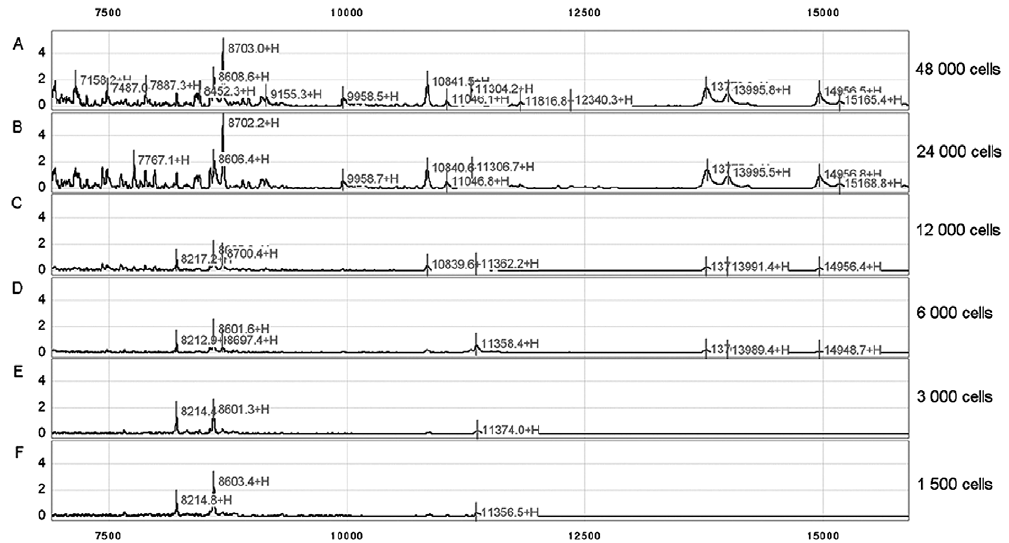
Fig. 2. Determination of the minimal input of B-cells for SELDI-TOF MS based protein profiling. Mass spectra were generated from different numbers of laser dissected germinal centre B-cells: 48,000, 24,000, 12,000, 6,000, 3,000 and 1,500 cells (Fig. 2A–F, respectively). For all spectra generated, the segment from 7,500–15,000 M/Z is shown. Prior to analysis, a lysate of approximately 48,000 laser dissected B-cells was quantified and corresponded to 4 ug of whole protein. from 48,000 and 24,000 germinal centre cells (Fig.